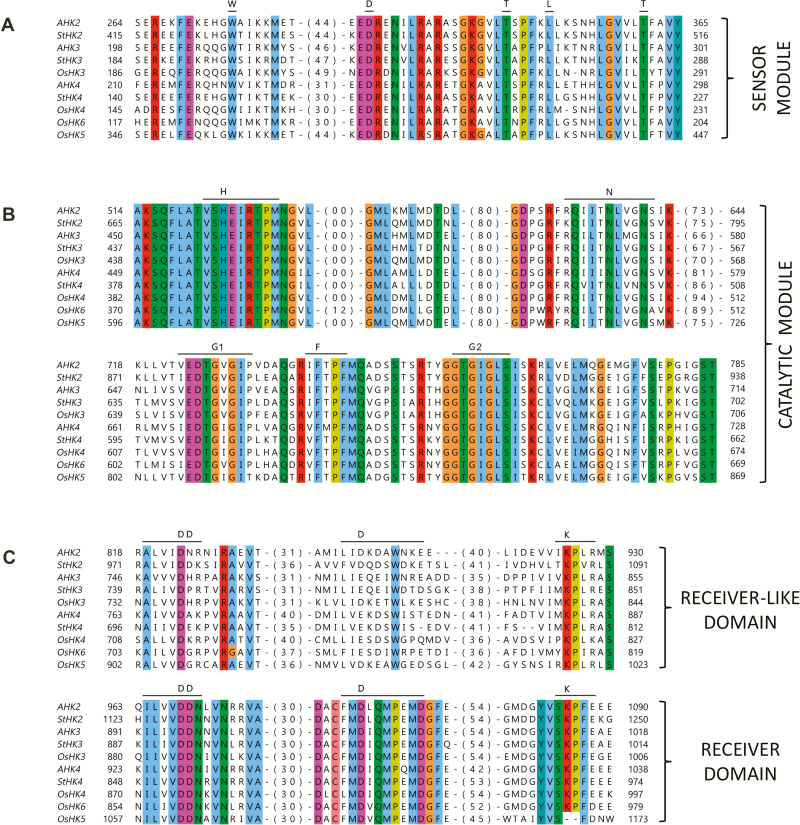
CK receptor sequence alignment. Consensus motifs and conserved amino acids are marked. AHK and OsHK correspond to Arabidopsis and rice proteins, respectively. Number of not shown amino acids is indicated in parentheses.